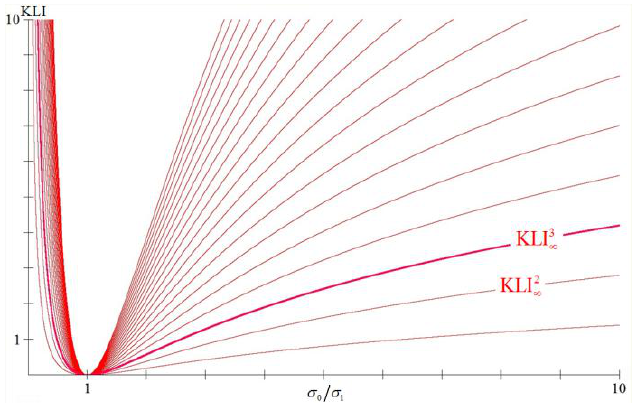
Figure 2. The graphs of the trivariate 3 KLI